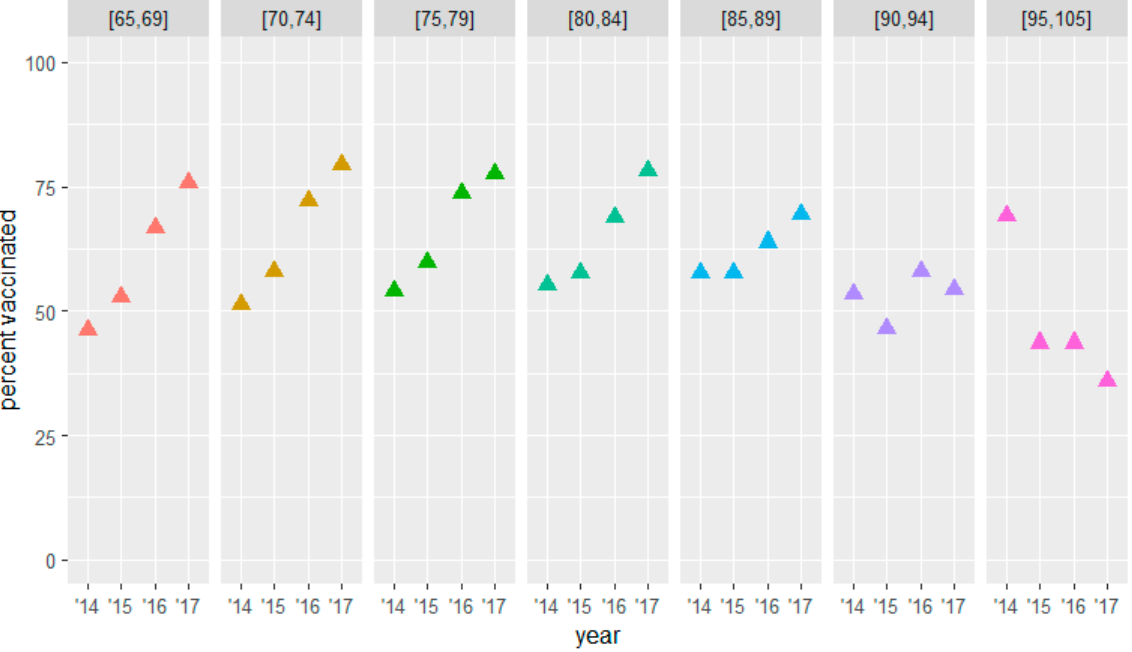
Table 6. Influenza vaccination uptake by age at baseline ≥ 65 group (without chronic condition).